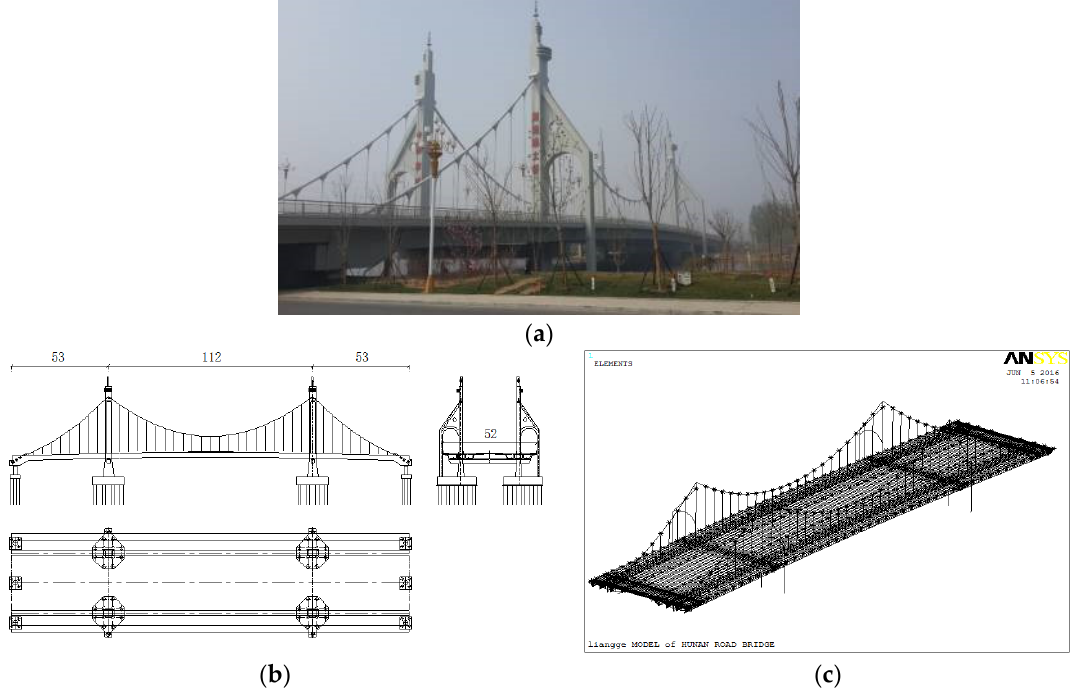
Figure 4. Description of Hunan Road Bridge: ( a ) Image of Hunan Road Bridge; ( b ) Image of Hunan Road Bridge; ( c ) FE model of Hunan Road